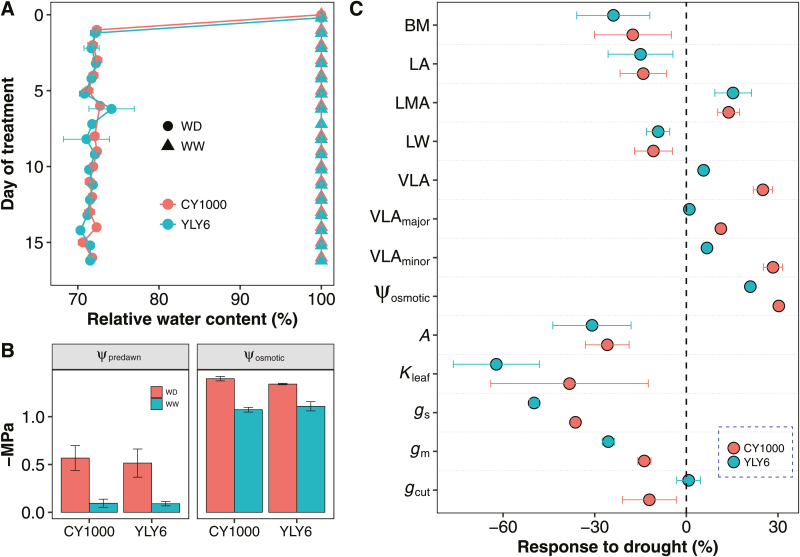
(A) Soil relative water content of the well-watered (WW) and water-deficient (WD) treatments. (B) Predawn leaf water potential (ψpredawn) and leaf osmotic potential (ψosmotic) of two rice genotypes after a 2-week drought treatment. See Supplementary Table S1 for definitions of the parameters. (C) Responses of leaf traits to 2 weeks of drought. The response was calculated as ln(XWD/XWW), where XWD and XWW were mean values of trait X under the WD and WW treatments, respectively.